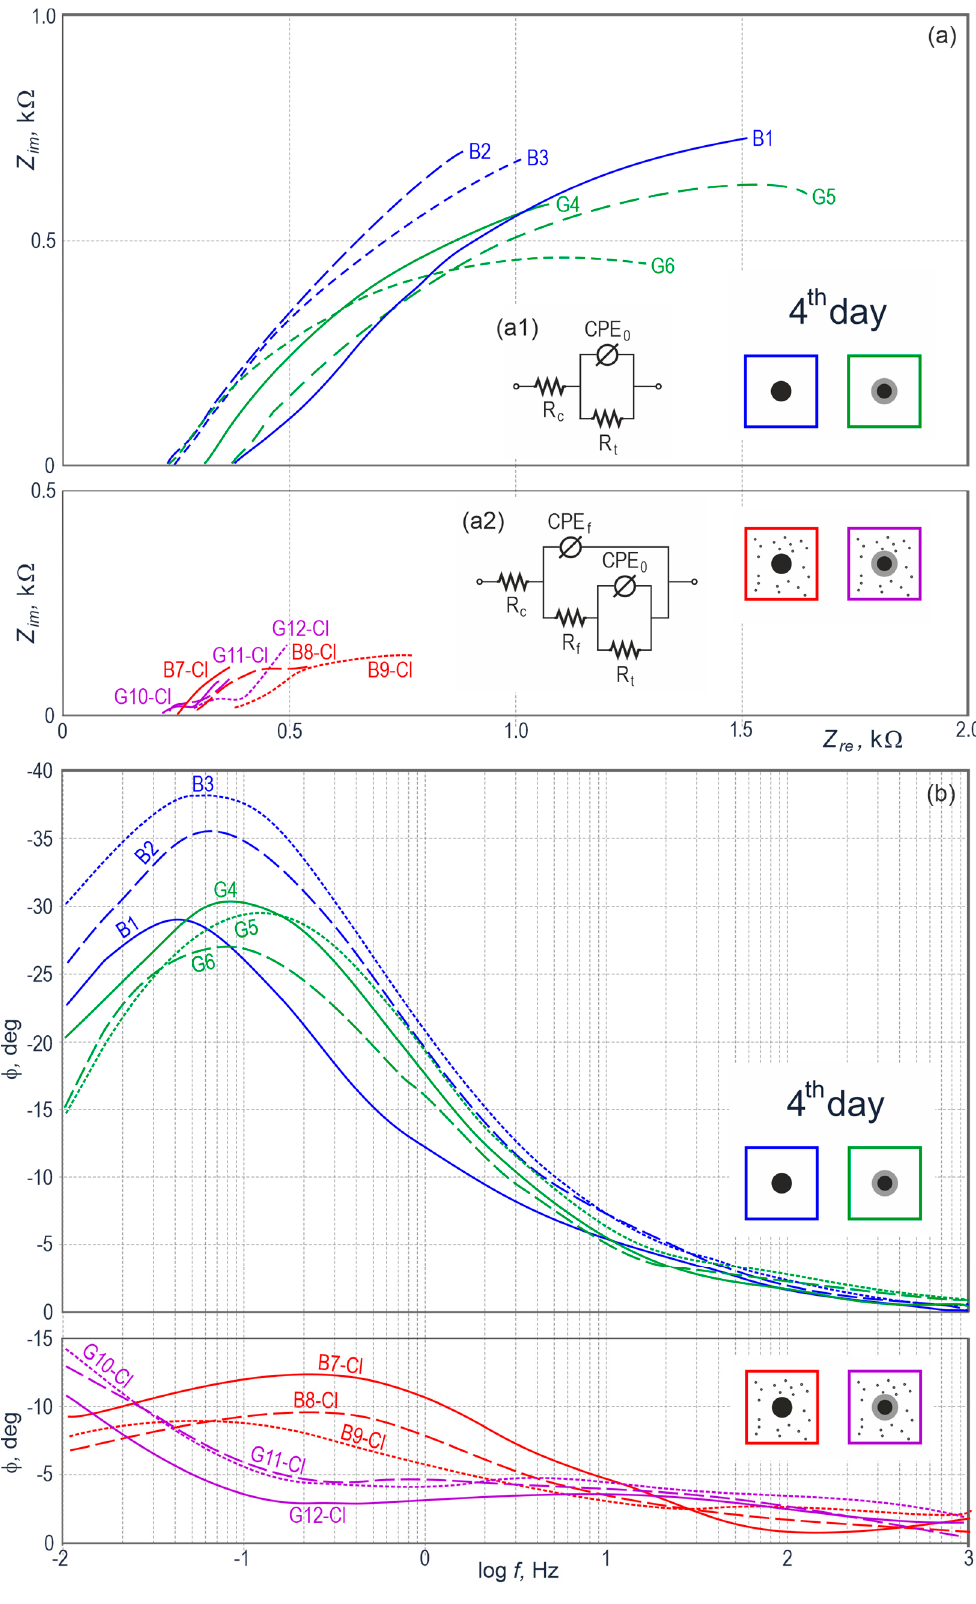
Figure 6. Results from impedance testing of steel reinforcement in concrete from 12 specimens on day 4 of measurements illustrated at the Nyquist ( a ) and Bode ( b ) plots, B —black steel in concrete without additives, G —galvanized steel in concrete without additives, B-Cl —black steel in concrete with chlorides, G-Cl —galvanized steel in concrete with chlorides; ( a1 ) electrical equivalent circuit for the B and G spectrum groups, ( a2 ) electrical equivalent circuit for the B-Cl and G-Cl spectrum groups